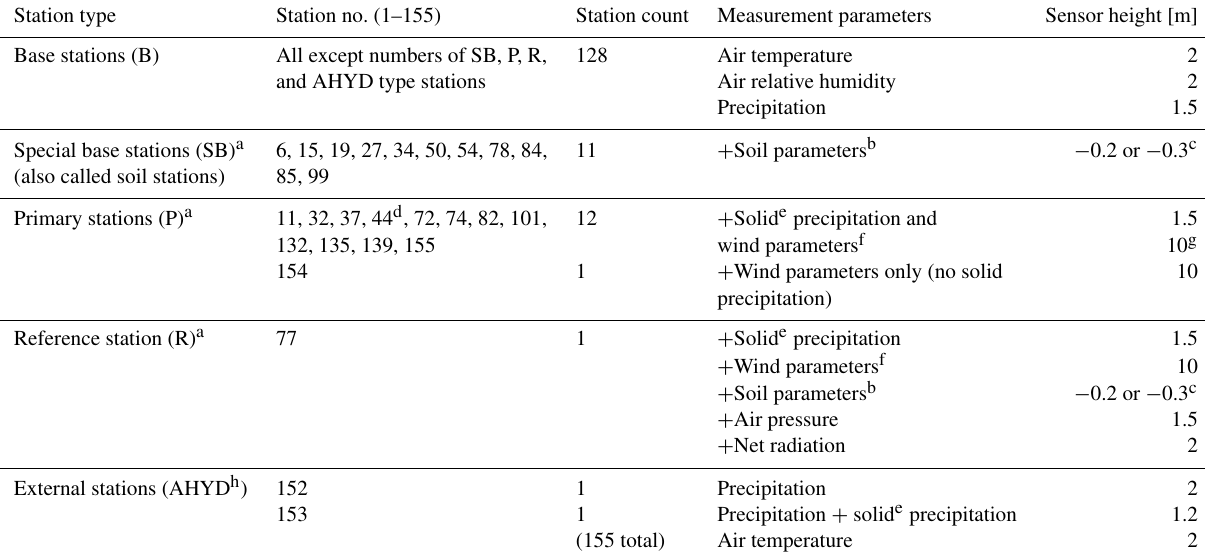
Table 1. Summary of WegenerNet Feldbach Region (FBR) station types, measured parameters, and sensor heights. Station type